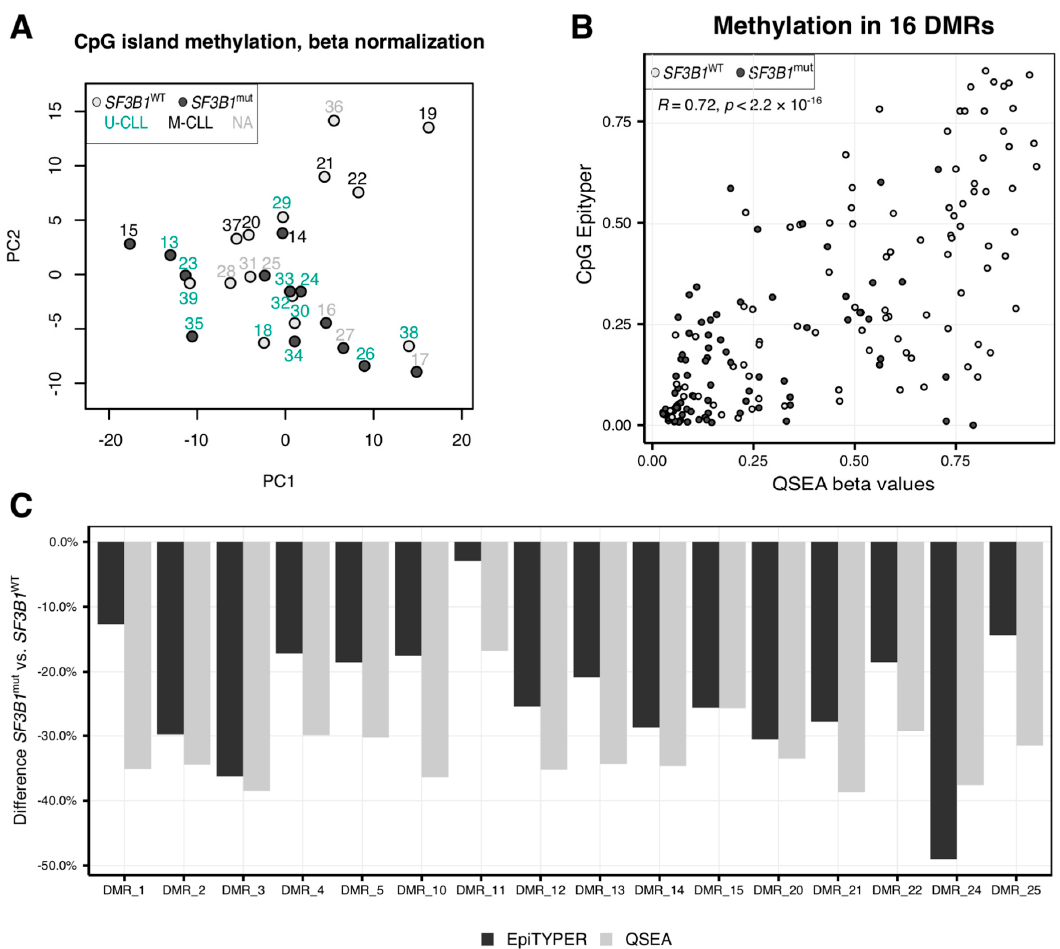
Figure 1. Hypomethylation in chronic lymphocytic leukemia (CLL) patients with SF3B1 mutation. ( A ) Principal component analysis (PCA) of the samples revealed clustering of the SF3B1 mut samples with darker points corresponding to the samples with a mutation. PCA was performed using beta normalized values for the 1,000 most variable 250 bp windows within CpG islands. Points colors correspond to the SF3B1 mutational status. Sample IDs were colored according to IGHV mutational status. ( B , C ) Validation of 16 from 67 differentially methylated regions (DMRs) identified with the subset of samples (6 SF3B1 WT and 6 SF3B1 mut ) using the EpiTYPER to estimate CpGs methylation levels within the DMRs: ( B )—correlation between EpiTYPER and beta methylation for each sample and every DMR/CpG; ( C ) comparison of the methylation difference between SF3B1 mut and SF3B1 WT CLL mean methylation levels.